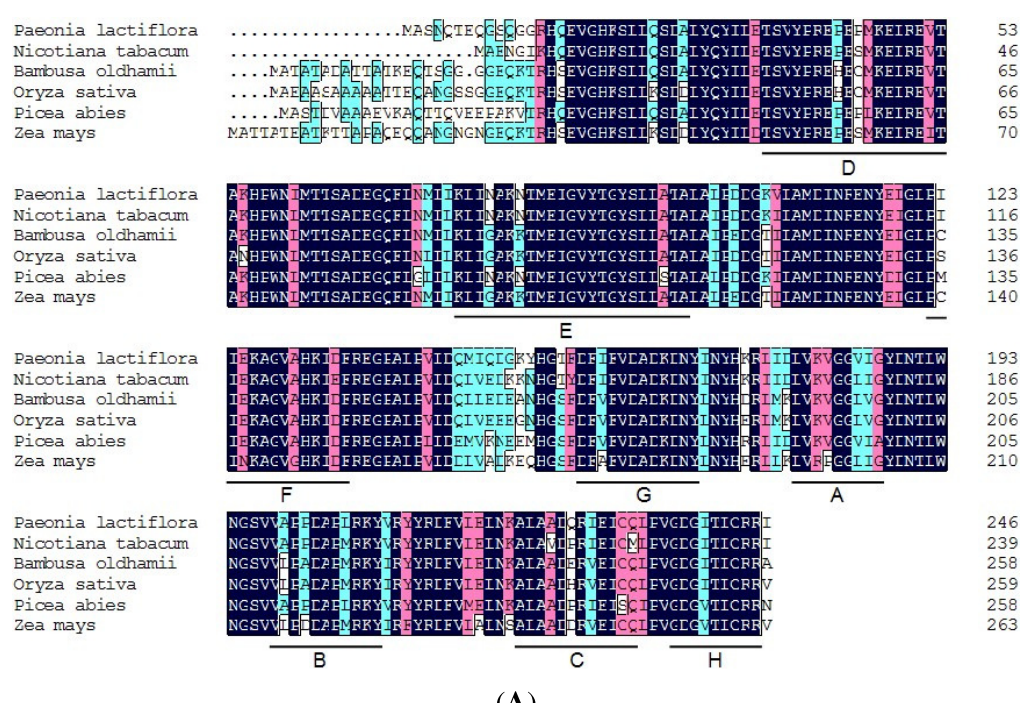
Figure 5. Sequence alignment and phylogenetic tree of CCoAOMT from Paeonia lactiflora other plants. ( A ) Sequence alignment; ( B ) Phylogenetic tree. The amino acid sequences were obtained from GenBank: Bambusa oldhamii (EF028662); Nicotiana tabacum (AF022775); Oryza sativa (AY644636); Picea abies (AM262870); Zea mays (AJ242981). Color indicates homology level, black = 100%, pink ≥ 75%, blue ≥ 50%. A, B and C are popular conserved sequence elements in plant methyltransferase; D, E, F, G and H are signature sequences of CCoAOMT